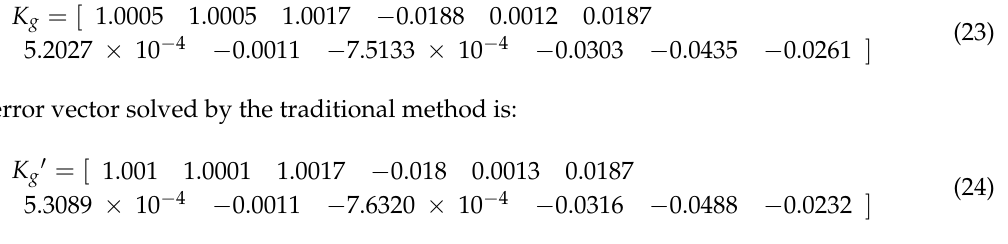
Table 3. Comparison of the Mean and Root Mean Square (RMS) (uncompensated method and the proposed method).